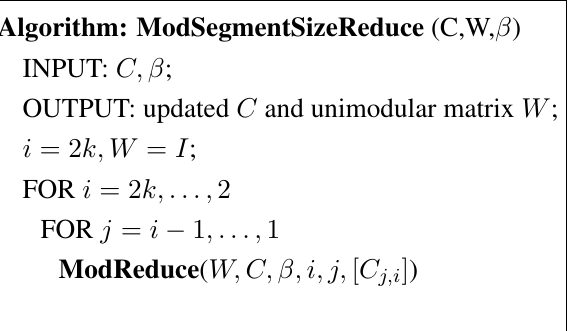
Figure 14. Size Reduction of a Segment Using Modular